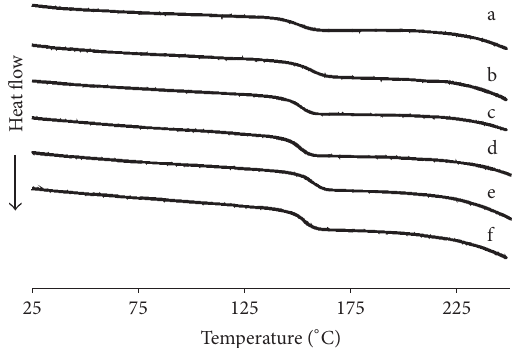
Figure 6: DSC thermograms of samples of the polymeric material obtained at different global conversions in the copolymerization of MMA/MAA (2/1, mol/mol): (a) 8.0, (b) 28.7, (c) 50.6, (d) 65.3, (e) 76.8, and (f) 89.7%.